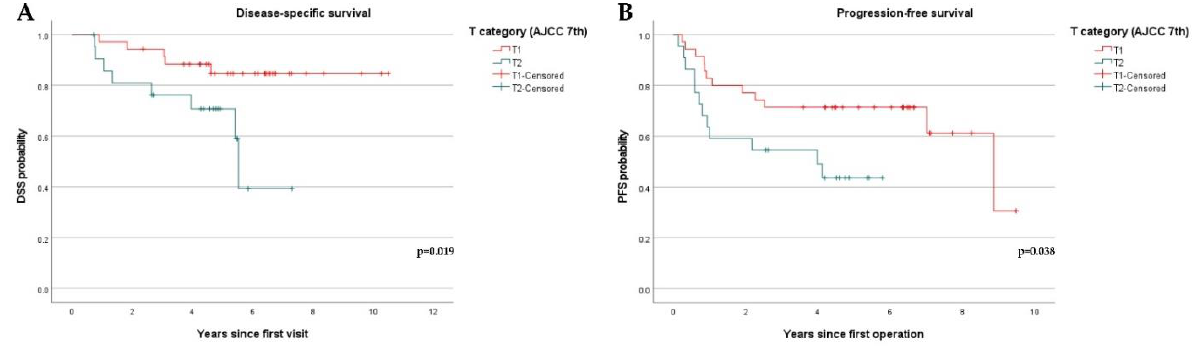
Figure 4. Kaplan–Meier curves showing disease-specific survival (DSS) and progression-free survival